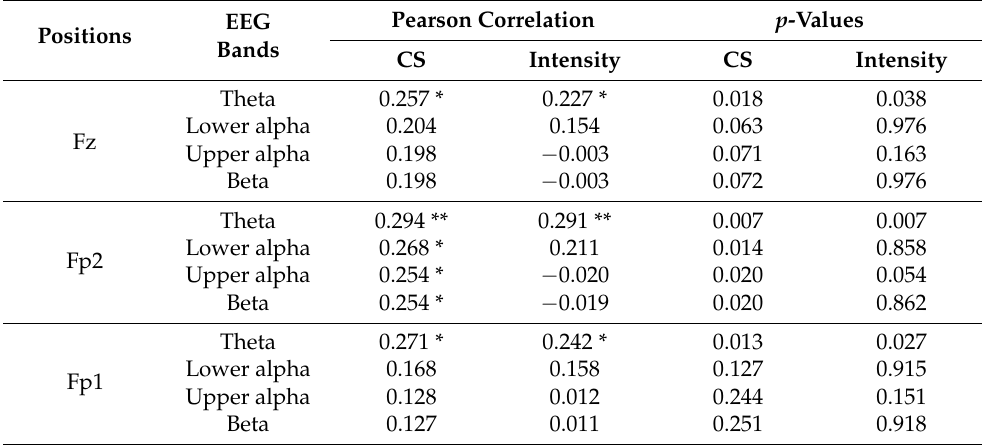
Table 3. Correlations among electroencephalography (EEG) bands, CDRI tests, and subjective ratings of cognitive state. Pearson Correlation p -Values EEG Positions Bands CS